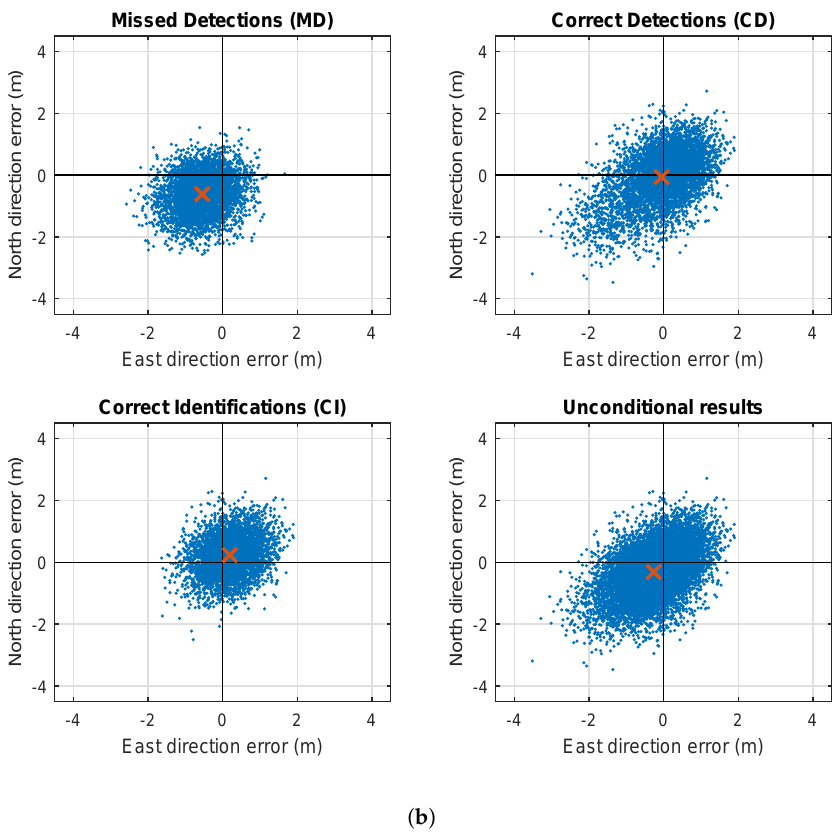
Figure 9. Horizontal position biases, b ¯ x | MD , b ¯ x | CD , b ¯ x | CI and b ¯ x , for GPS-only pseudorange bias of size b 5 = 2.5 σ ˆ in GPS PRN 5 ( a ) and GPS+Galileo pseudorange bias of size b 64 = 2.5 σ ˆ b 5 64 ( b